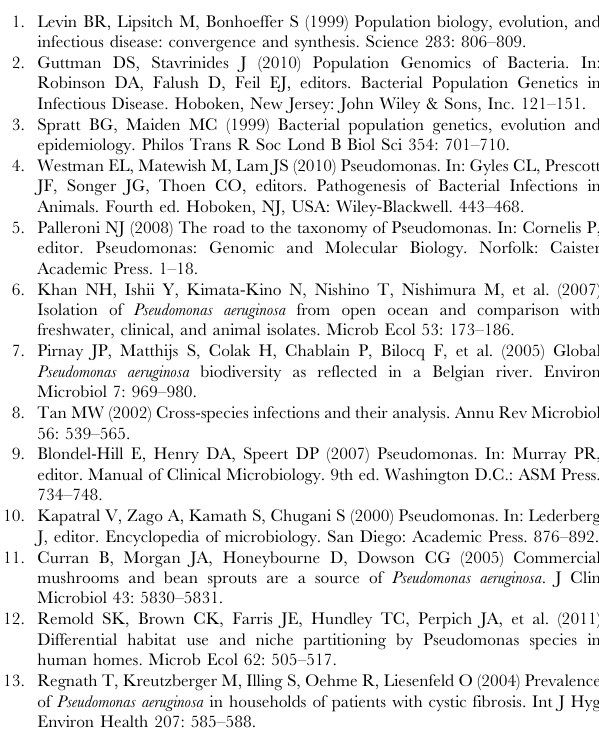
Table S1 List of the sources, sampling details, relevant epidemiological, clinical and geographical characteris- tics, multilocus sequence typing data and results of eBURST analyses for the 501 Pseudomonas aeruginosa